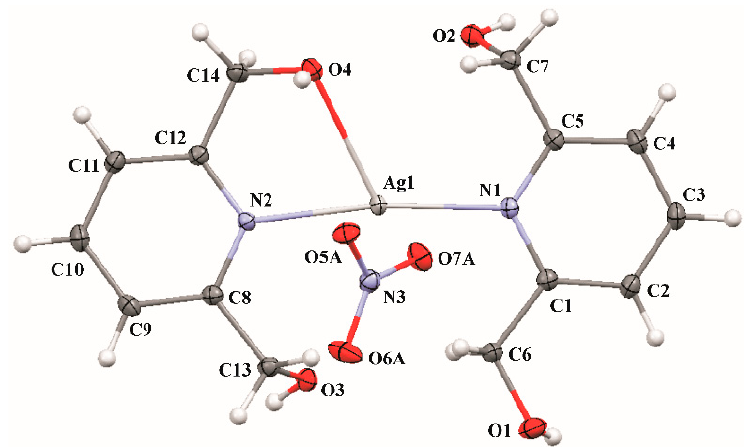
Figure 1. The molecular structure of the title Ag(I) complex ( MERCURY [36] representation), with atom labels and 50% probability displacement ellipsoids for non-H atoms. Only the major component (A) of disordered oxygen atoms in the anion molecule (NO 3 − ) is shown (minor components B are omitted for clarity).